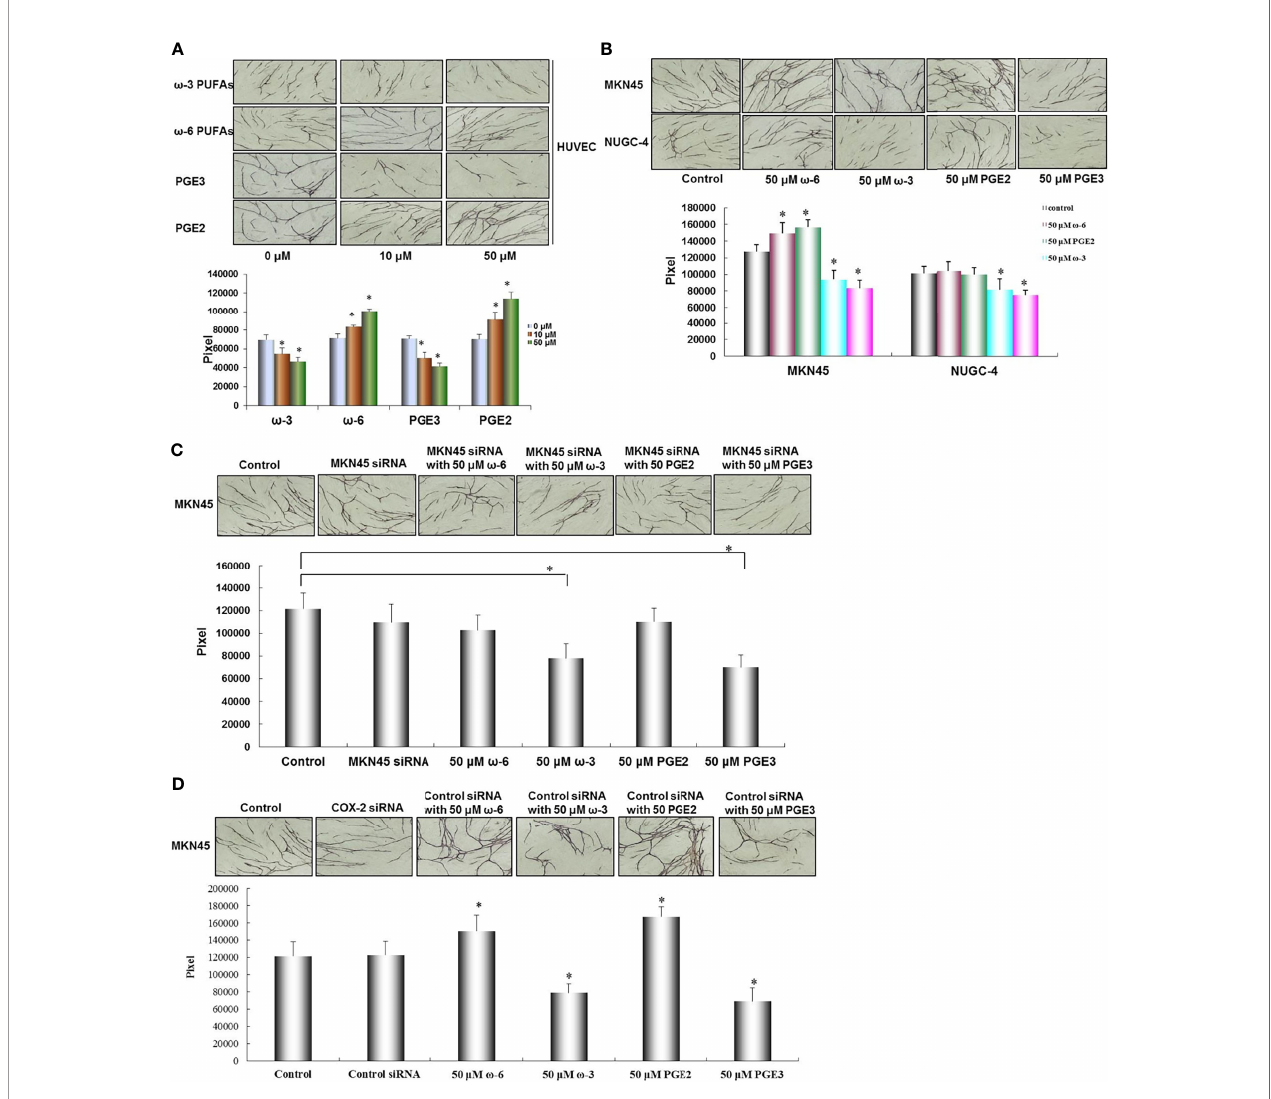
FIGURE 6 | Effect of w -3, w -6 PUFAs, PGE2, PGE3, and gastric cancer cells on HUVEC tube formation. HUVEC tube formation was signi fi cantly promoted by w -6 PUFAs and PGE2. On the contrary, HUVEC tube formation was also signi fi cantly inhibited by w -3 PUFAs and PGE3 (A) . HUVEC tube formation was signi fi cantly enhanced by coculture with MKN45 cells compared with NUGC-4 cells. In MKN45 cocultured system, w -6 PUFAs and PGE2 signi fi cantly promoted HUVEC tube formation, but this promoted action was inhibited by COX-2 siRNA. HUVEC tube formation was decreased by w -6 PUFAs and PGE2 in MKN45 and NUGC-4 cocultured system (B , C) . To con fi rm the speci fi city of COX-2 siRNA for inhibition of COX-2 in MKN45 cells, control siRNA was set as a control in the MKN45 cells. The results showed that w -6 and PGE2 signi fi cantly enhanced angiogenesis, while w -3 and PGE3 signi fi cantly reduced tumor angiogenesis in cocultured system (D) . Multiple comparisons used the method of one-way ANOVA followed by the SNK test. Bars indicate SD, * p < 0.01. The experiments were performed in